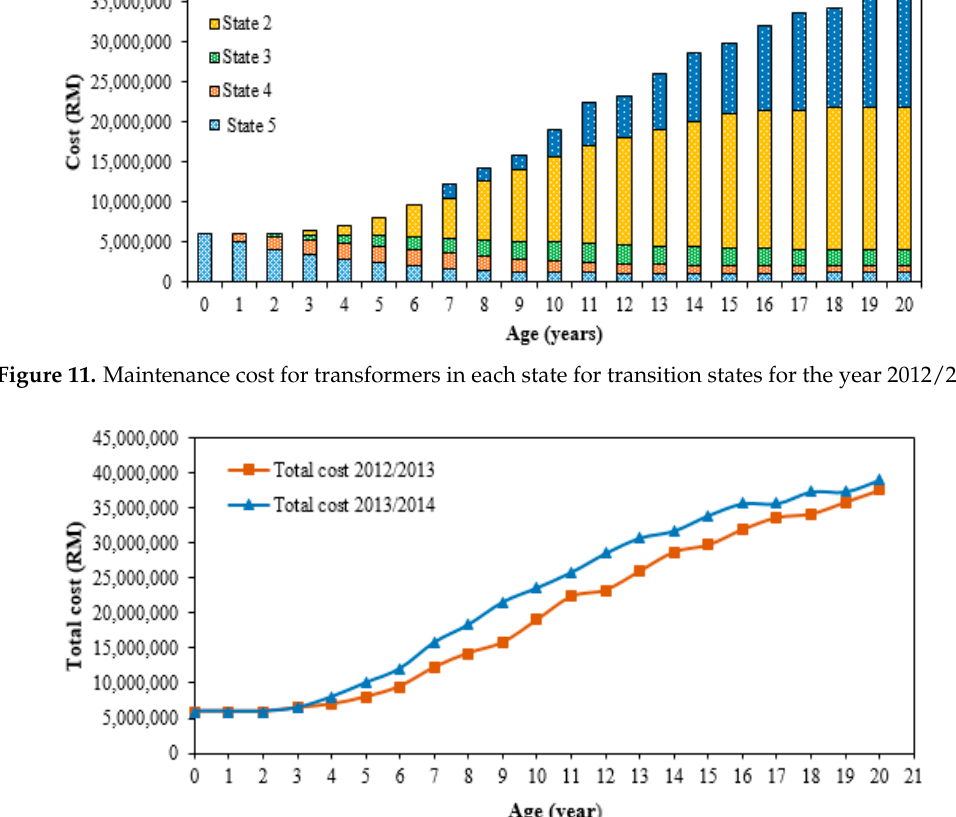
Figure 12. Total estimated maintenance cost for transformers in each year based on transformer transition states for the year 2012/2013 and 2013/2014.